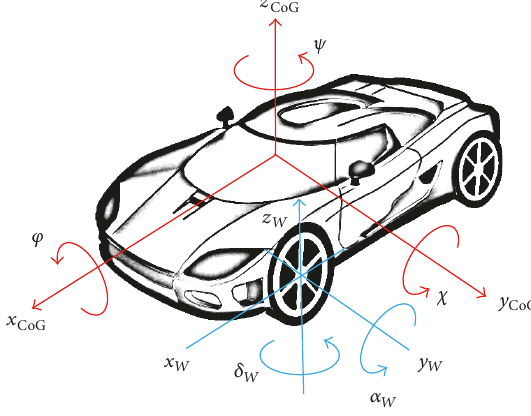
Figure 2: Degrees of freedom of a